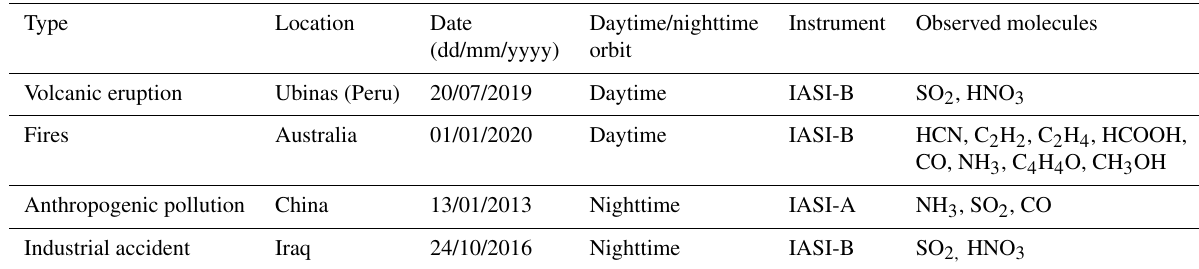
Table 2. Brief description of the four case studies analyzed in this section. Type Location Date Instrument Volcanic eruption